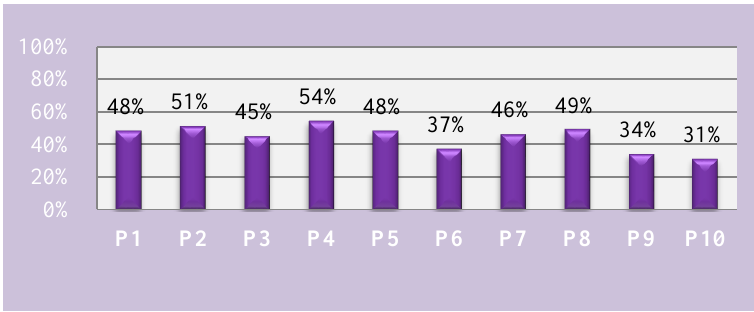
Fig. 3. Percentage of performance for each